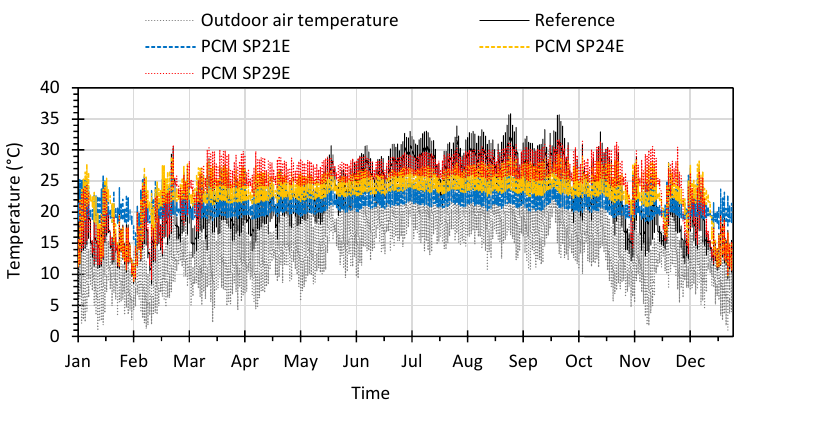
Figure 6. Annual indoor air temperature results: reference model vs. model with thermally enhanced solutions comprising different PCM operating temperature ranges.